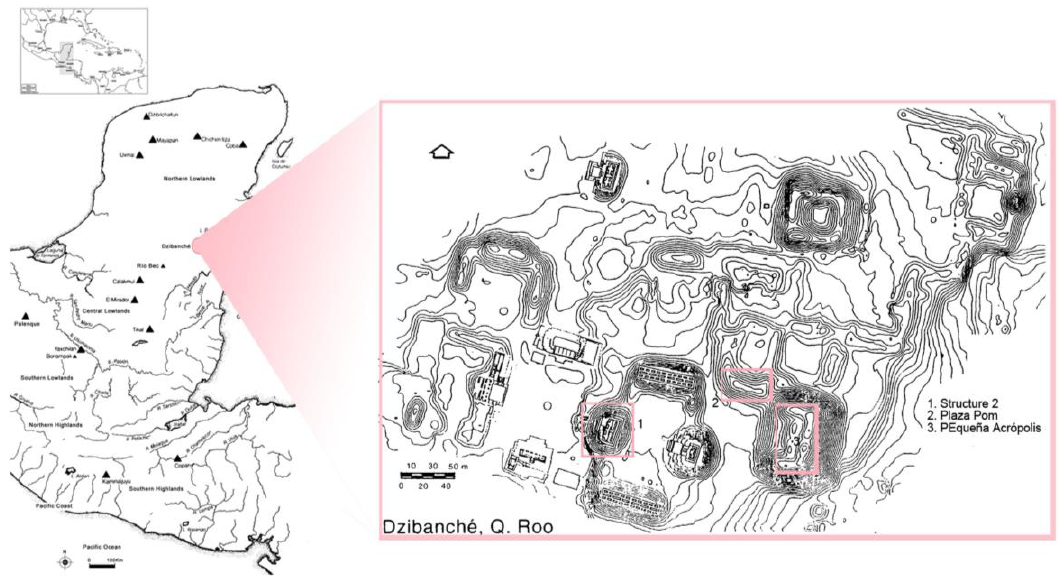
Figure 1. Location of Dzibanché and the studied buildings.